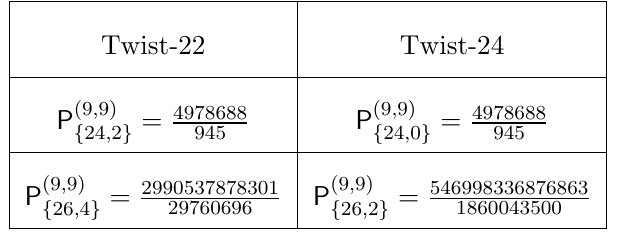
Table 3 . Nine-loop sum rule P (9 ;